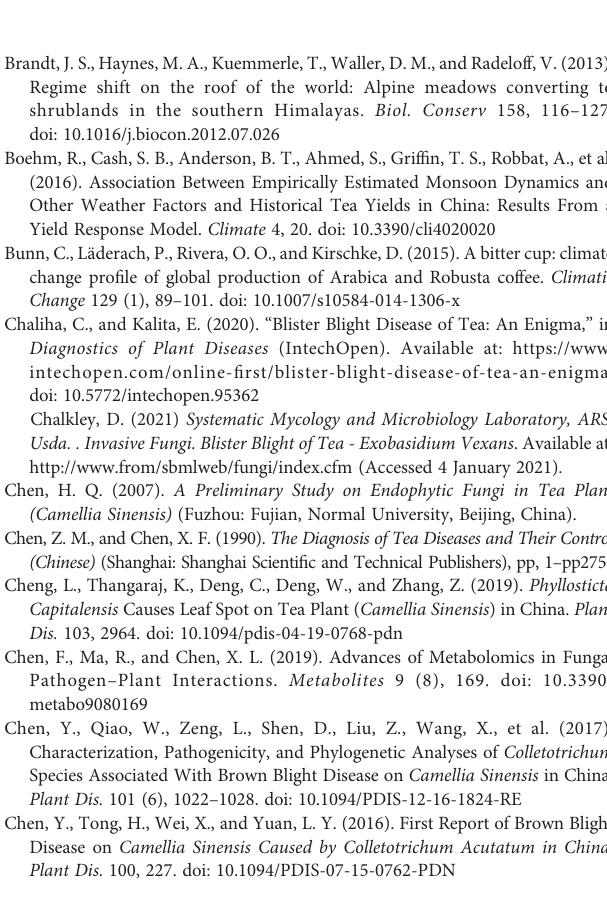
Supplementary Figure 3 | Average annual temperature map of the world. Baseline tea plantations and selected pathogen occurrence areas. Supplementary Figure 4 | Precipitation ranges for tea and its pathogens. Supplementary Figure 5 | Annual relative humidity map of the world. Baseline tea plantations and selected pathogen occurrence